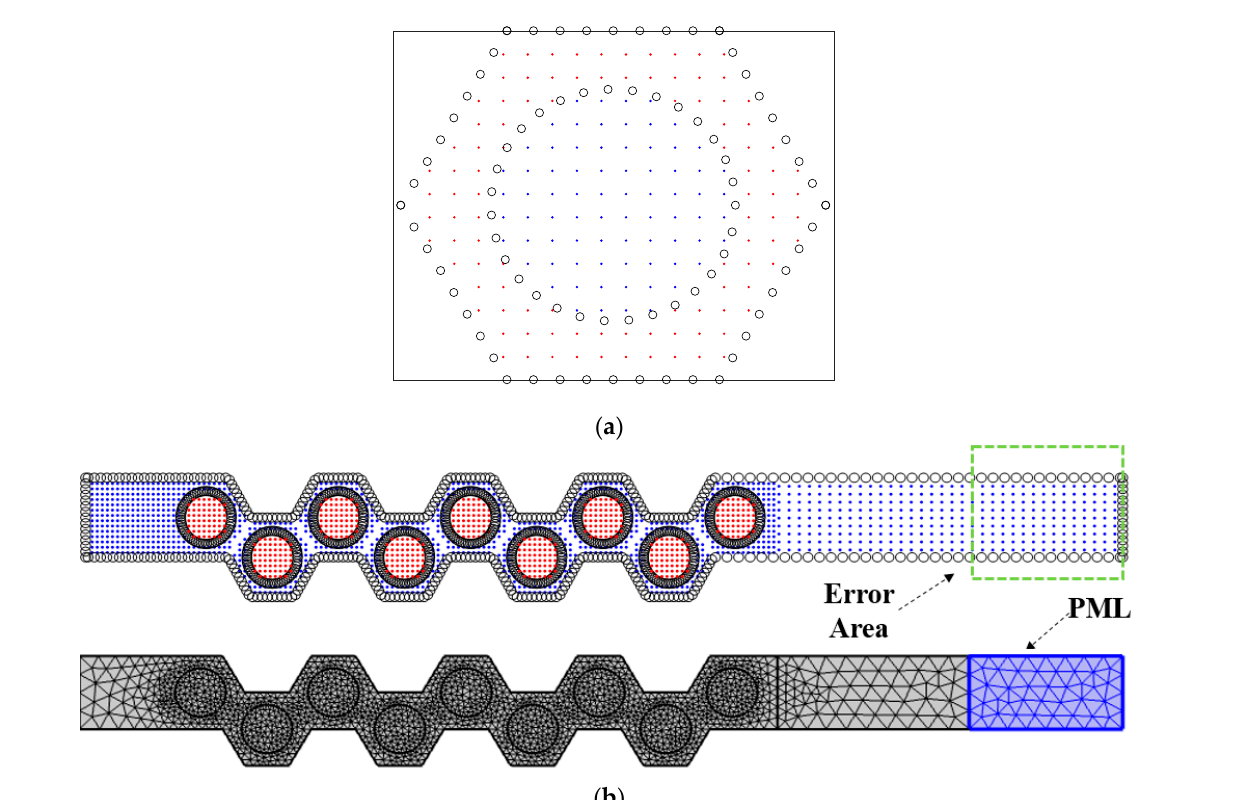
Figure 16. Nodes distribution for ( a ) the unit cell of phononic crystal with a hexagon matrix including a circular scatterer; ( b ) Node distribution with error region and element distribution with PML region for the phononic crystal with semi-infinite periodic structure in the y -direction.